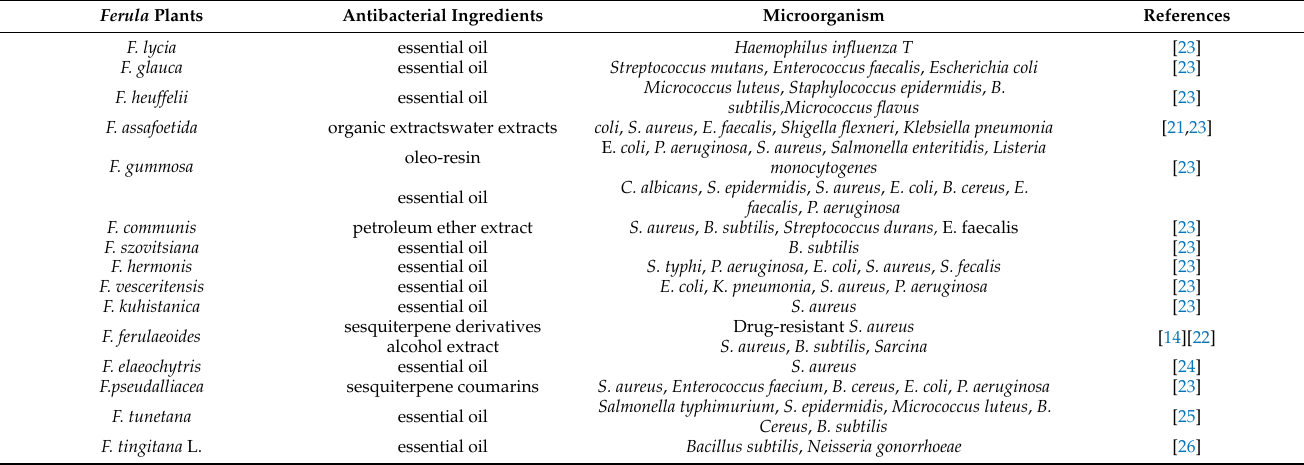
Table 4. Antibacterial Effect of Ferula